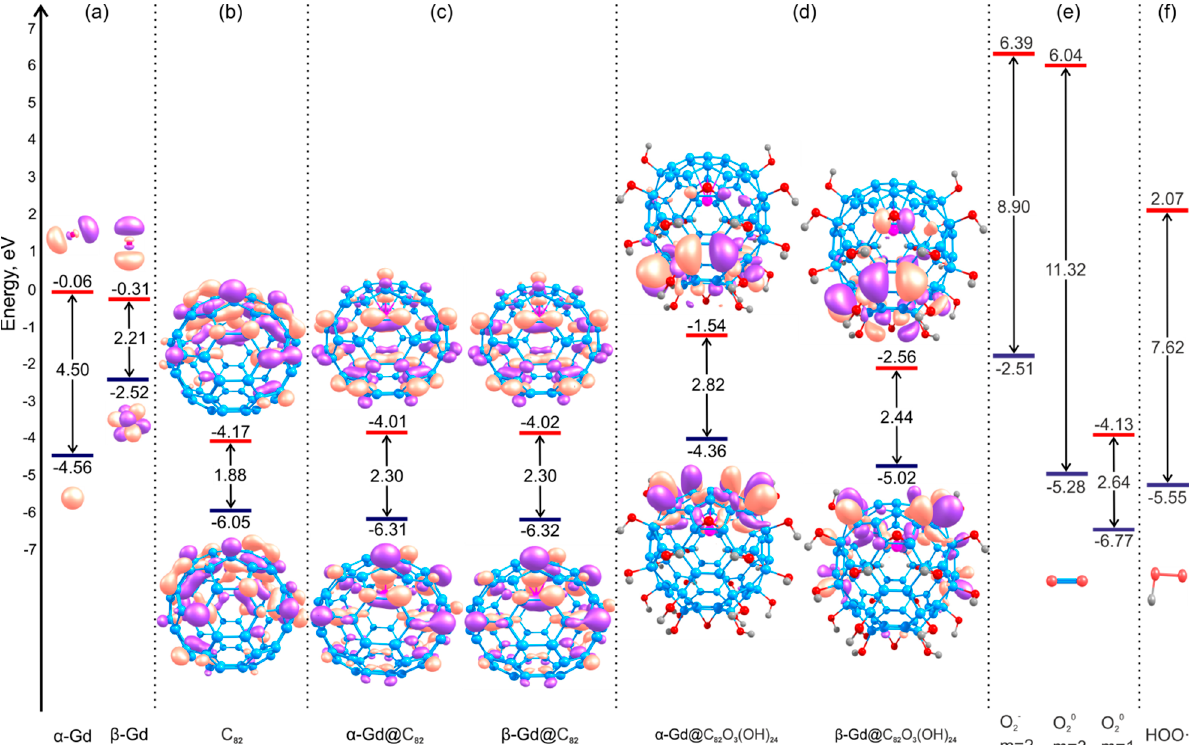
Figure 3. Diagram of the boundary molecular orbitals. ( a ) Gd, ( b ) C 82 , ( c ) Gd@C 82 , ( d ) Gd@C 82 O 3 (OH) 24 , ( е ) O 20 ( m = 1, m = 3), O 2 − ( m = 2), and ( f ) HOO • in the solvent. The HOMO and LUMO levels are shown in blue and red colors, respectively. The number between the HOMO and LUMO is the energy gap ( ∆ E HOMO-LUMO ) in eV. The regions of the positive and negative wave functions on the molecules are shown in pink and purple